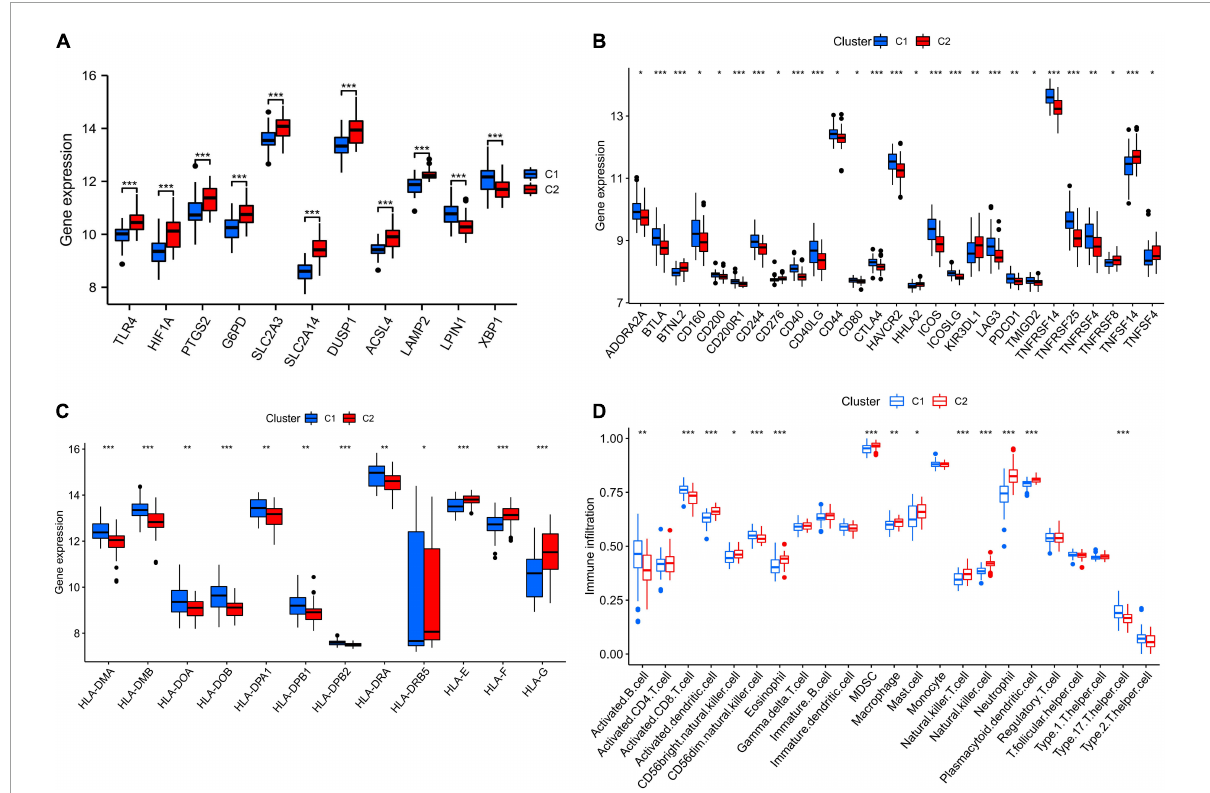
FIGURE9 The features of the immunological microenvironment differ between subtypes. Box plots showing that there were differences in hub genes (A) , immune checkpoints (B) , HLA genes (C) , and immune cell infiltration (D) between the two subtypes. * p < 0.05, ** p < 0.01, and *** p <